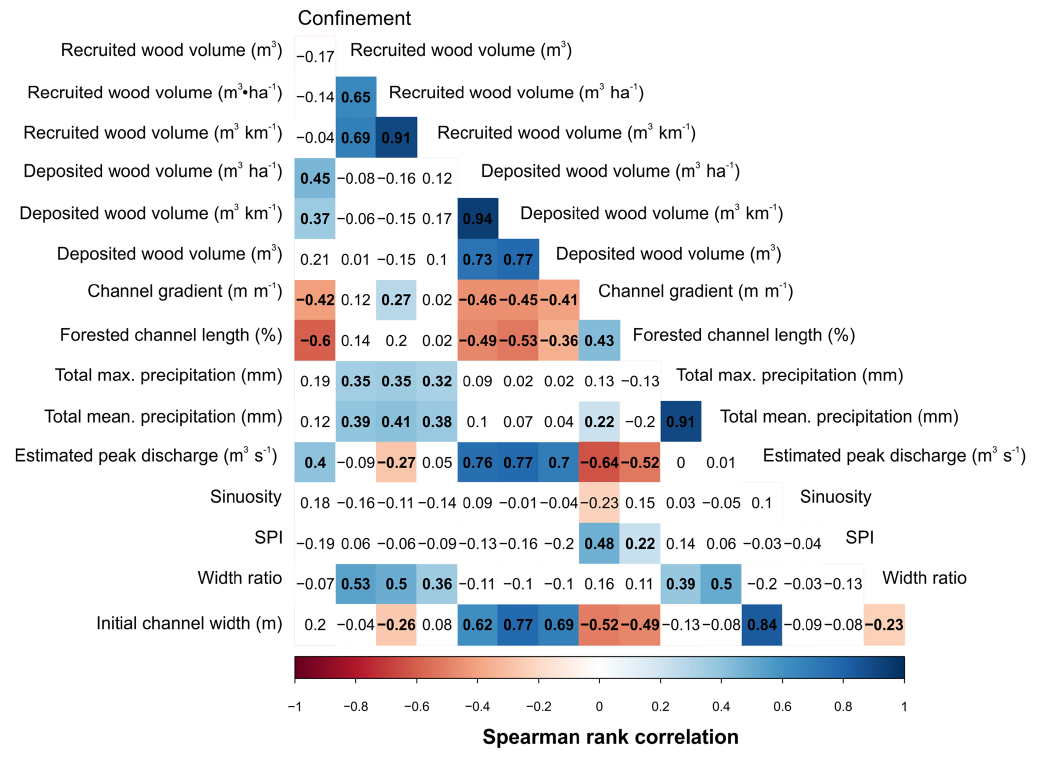
Figure 5. Spearman rank correlation matrix of all variables included in the analyses and for all sub-reaches together. Values show the Spearman rank results (significant correlations are in bold). Red colors show significant negative correlations, blue shows significant positive correlation, and white shows insignificant correlations. Table 3. Spearman rank correlation matrix for the width ratio versus different variables and for all sub-reaches, only Emme sub-reaches, and only tributary sub-reaches showing widening (i.e., width ratio > = 1 . 2). Bold indicates significant correlation. Width ratio Variables Variables Variables (all sub-reaches with (Emme sub-reaches with (tributary sub-reaches width ratio = > 1 . 2) width ratio = > 1 . 2) with width ratio = > 1 . 2) Confinement index − 0 .